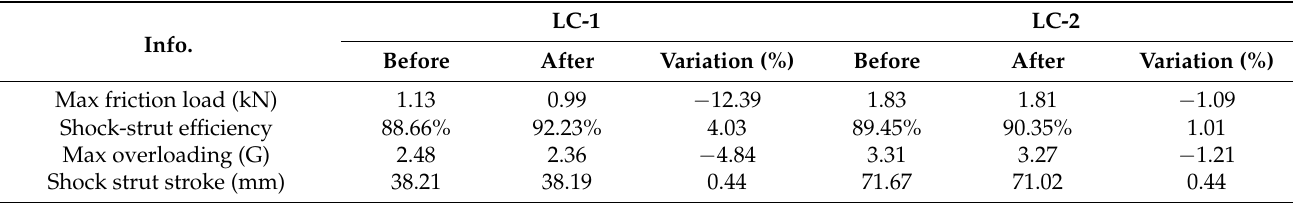
Table 11. Comparison of the design optimization